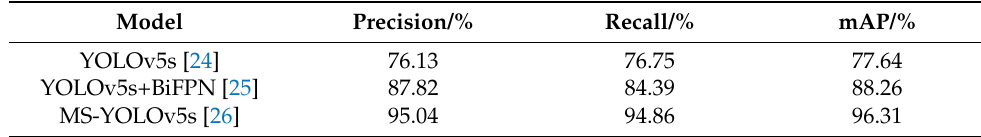
Figure 14. Di ff erent model training curves. Figure 14. Different model training curves. Table 4. Experimental results of different